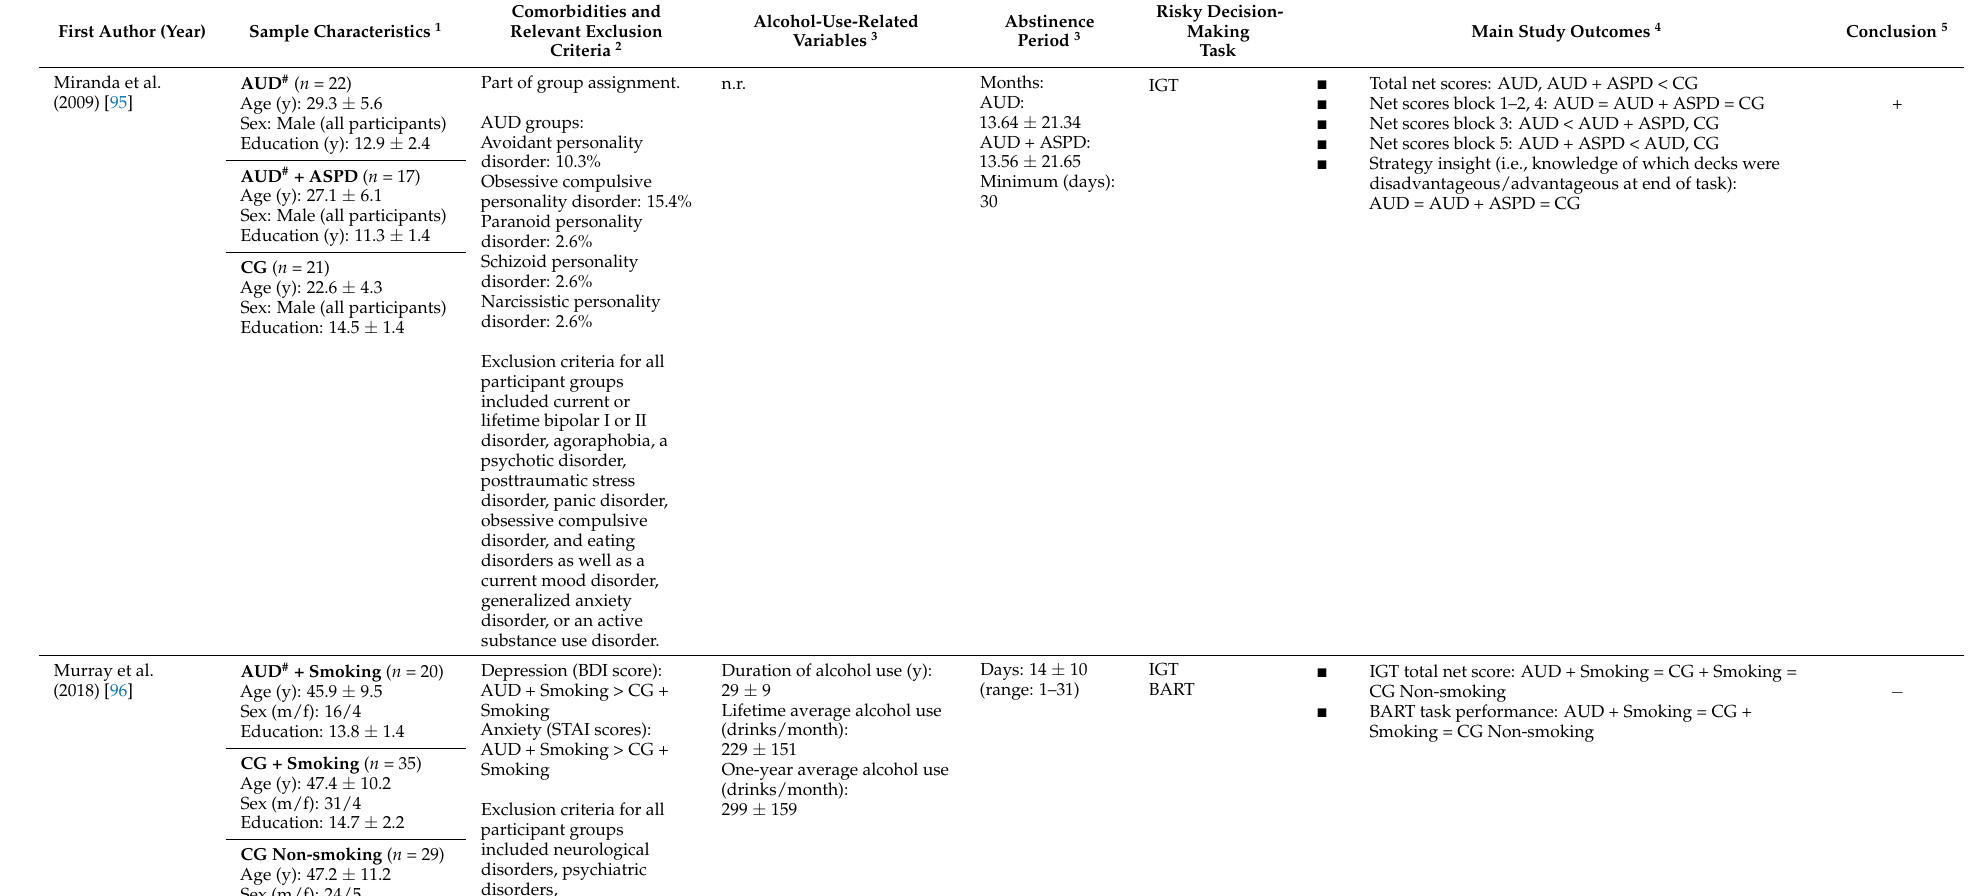
BART task performance: AUD + Smoking = CG + Smoking = CG